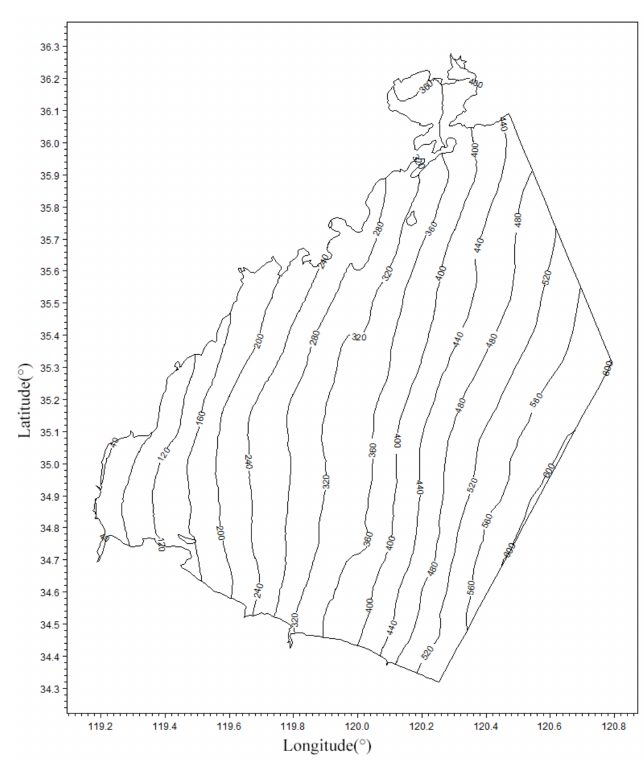
Figure 6. Chart datum geodetic height model (unit: